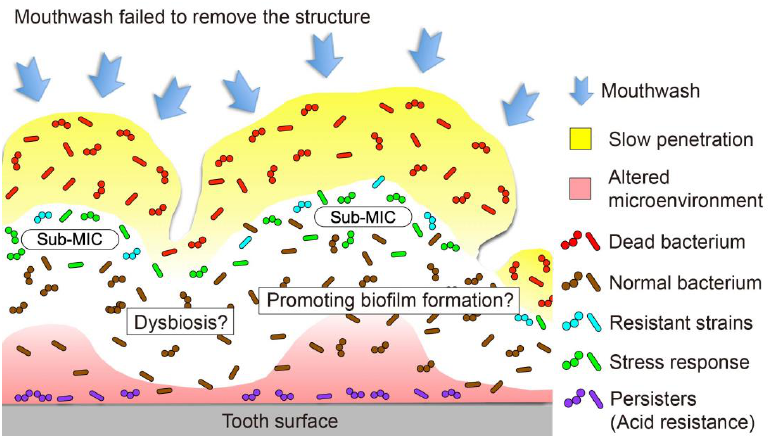
Figure 5. Posible adverse reactions inside the mature oral biofilm. Exposure of a mature oral biofilm to mouthwash is associated with several possible adverse reactions, such as the emergence of a re- sistant strain, effects of the residual structure, enhanced pathogenicity following retarded penetra- tion, and ecological changes to the microbiota.